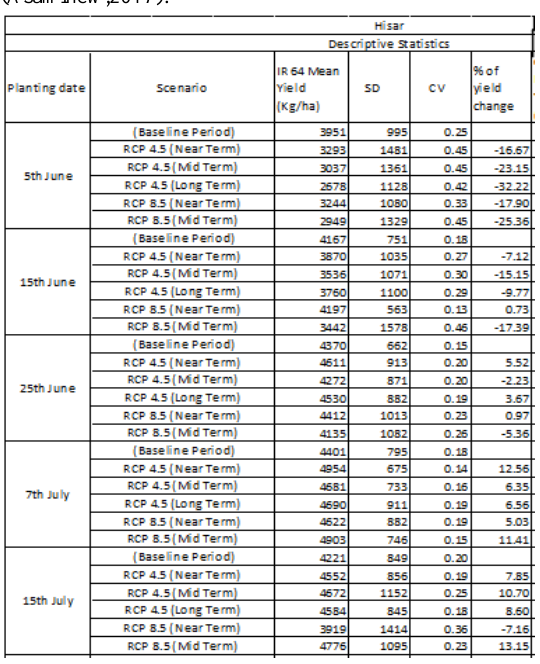
Table 9: Statistical summary of simulated rice yield under future scenarios with different sowing